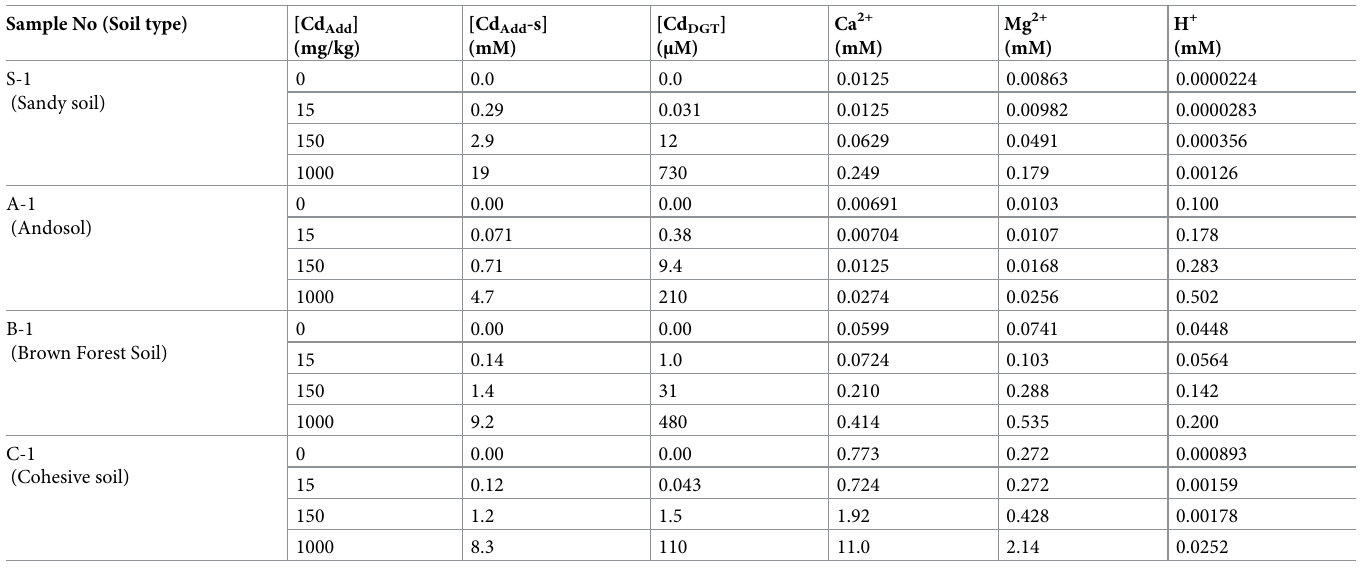
Table 3. Cation concentrations (mM and μ M) at equilibrium (day 3) for artificially contaminated soils S-1, A-1, B-1 and C-1. Sample No (Soil